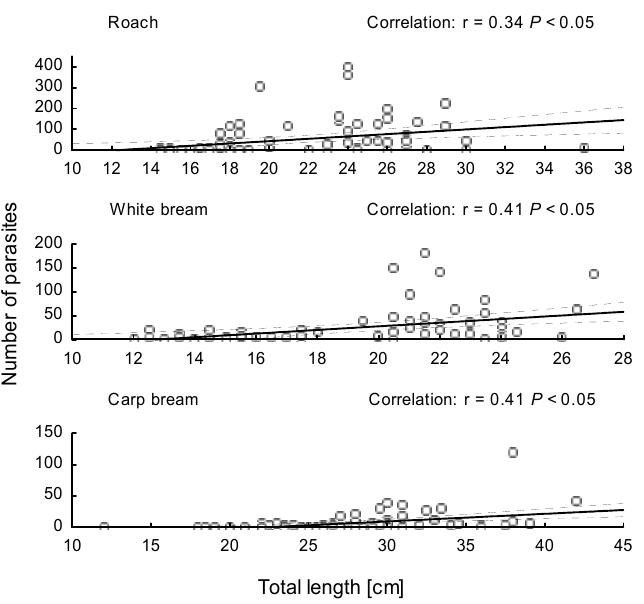
Fig. 7. Relationship between the number of P. cuticola and the total length (TL) of fish from western part of OÊwin